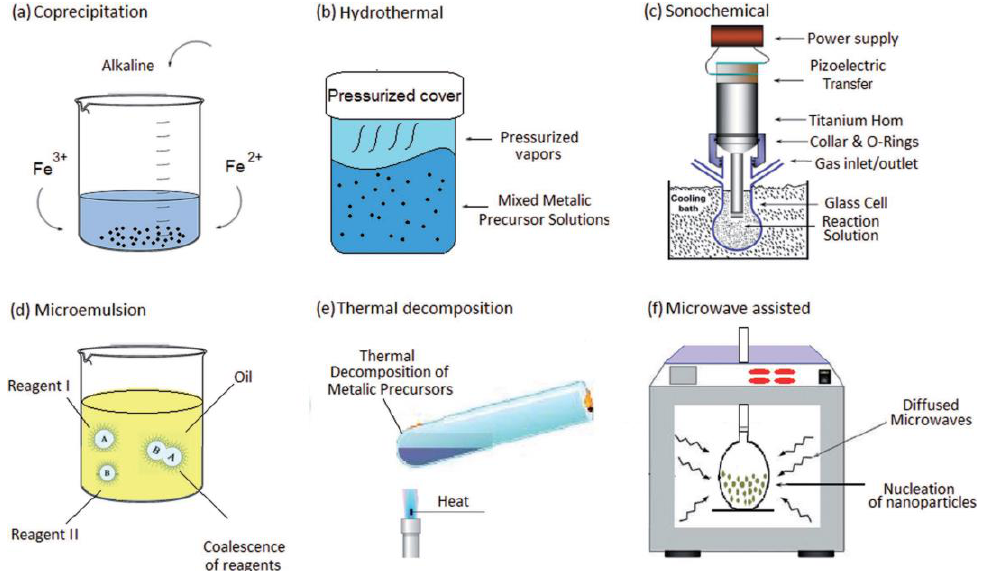
Figure 3. Schematics of distinct wet-chemistry hydrolytic and non-hydrolytic strategies for the syn- thesis of magnetic nanoparticles, ( a ) co-precipitation, ( b ) hydrothermal, ( c ) sonochemical, ( d ) micro- emulsion, ( e ） thermal decomposition, and ( f ) microwave assisted process. Reprinted with permis- sion from [23], John Wiley & Sons, Inc.